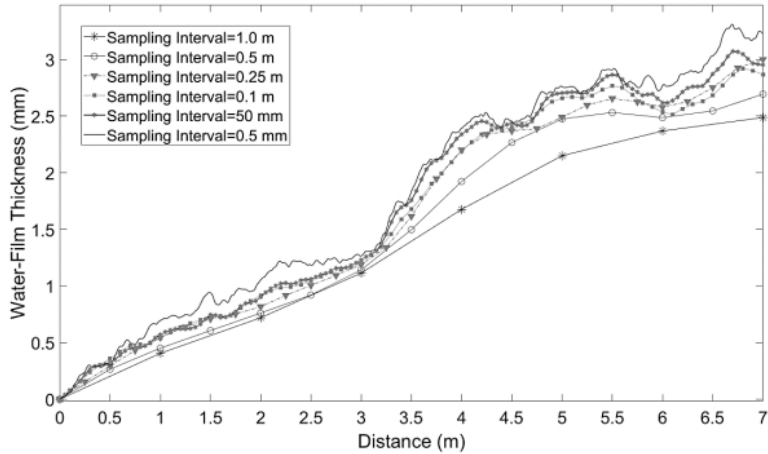
Figure 9. Water-film thickness estimation results using different sampling intervals. Table 2. Time Consumption for Different Sample Intervals.